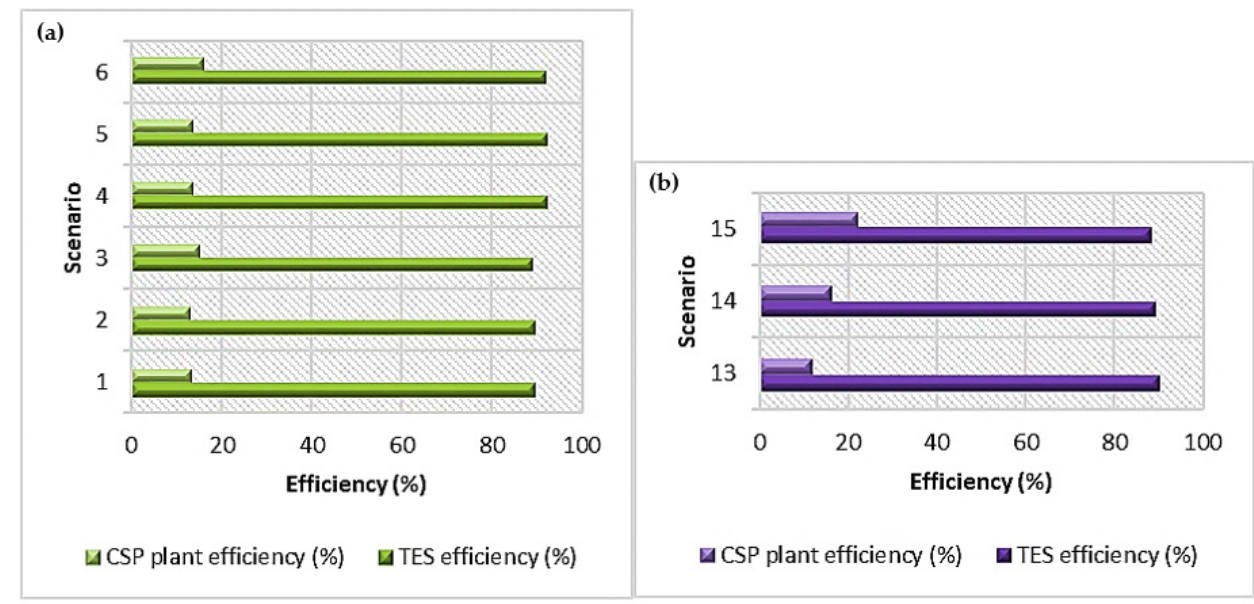
Figure 7. CSP plant efficiency and TES efficiency of ( a ) PT power plants and ( b ) SPT power plants under regular TES medium. Table 12. Solar power tower plant LCOE analysis for 50 MW installed capacity with regular storage medium.